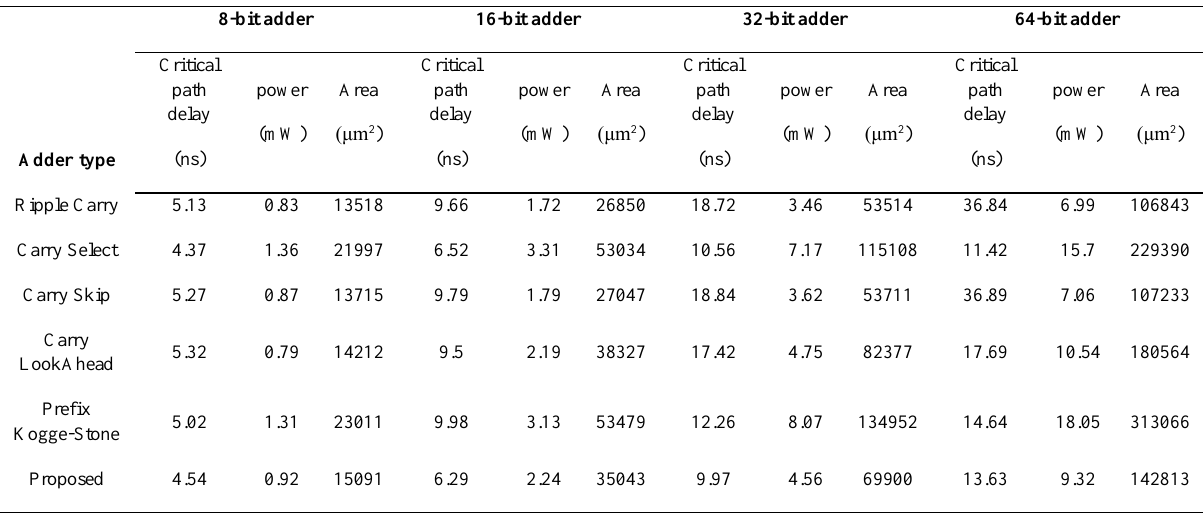
Figure 13. Comparison of the proposed fast adder with other fast adders in terms of critical path delay in a typical speed. Table 2. Comparison of the proposed fast adder with other fast adders in terms of delay, area, and power consumption in a typical speed with t = 25 °C and V supply = 1.80 v.